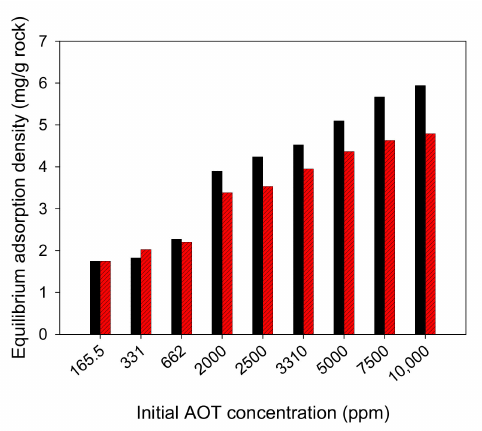
Figure 6. Adsorption of the eutectic mixture (red, shaded columns) and of pure AOT (black columns) in crushed sandstone as a function of the initial surfactant concentration.